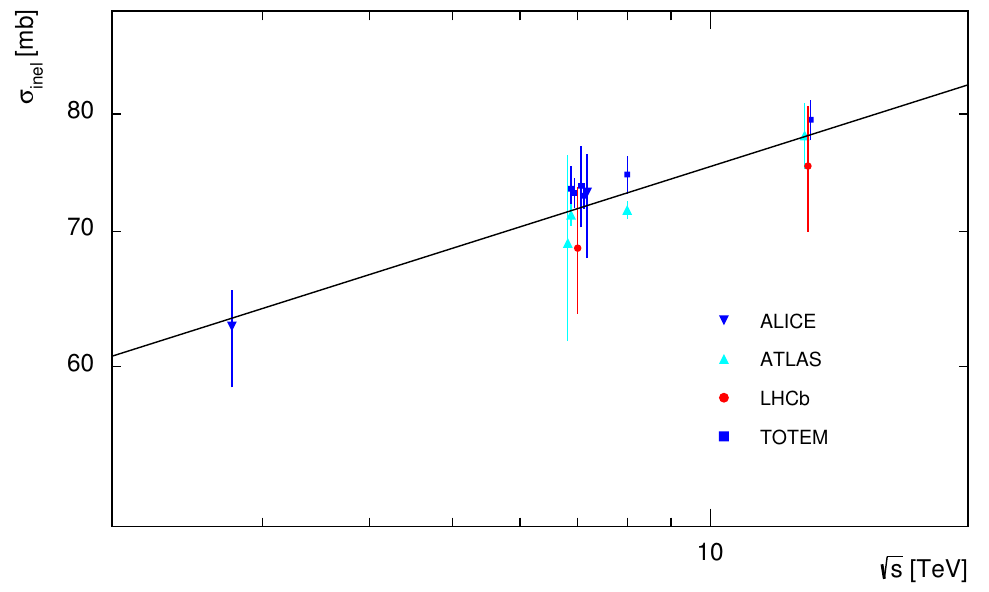
Figure 3 . Measurement of the total inelastic proton-proton cross-section at the LHC at centre- of-mass energies of 2.76, 7, 8 and 13 TeV. Results are shown from the ALICE [8], ATLAS [9{12] and TOTEM [16{21] collaborations. For better visibility, measurements at the same energy are drawn at slightly displaced locations. The error bars show the total uncertainties, with positive and negative uncertainties of the respective results independently added in quadrature. The line shows the result from a power-law